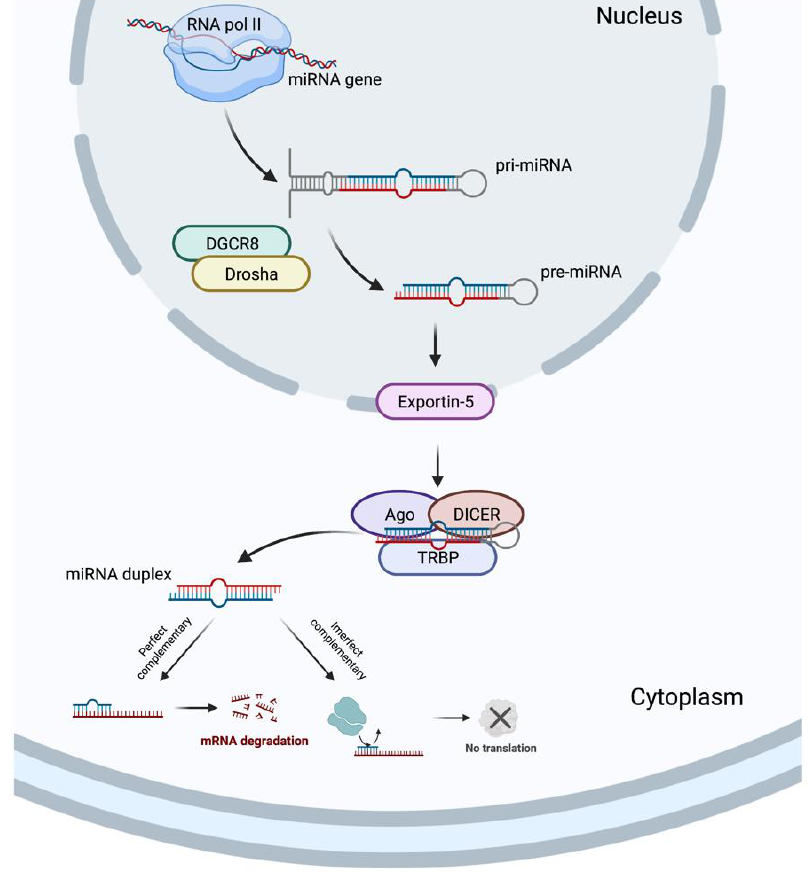
Figure 3. MicroRNA biogenesis. Created with BioRender.com.